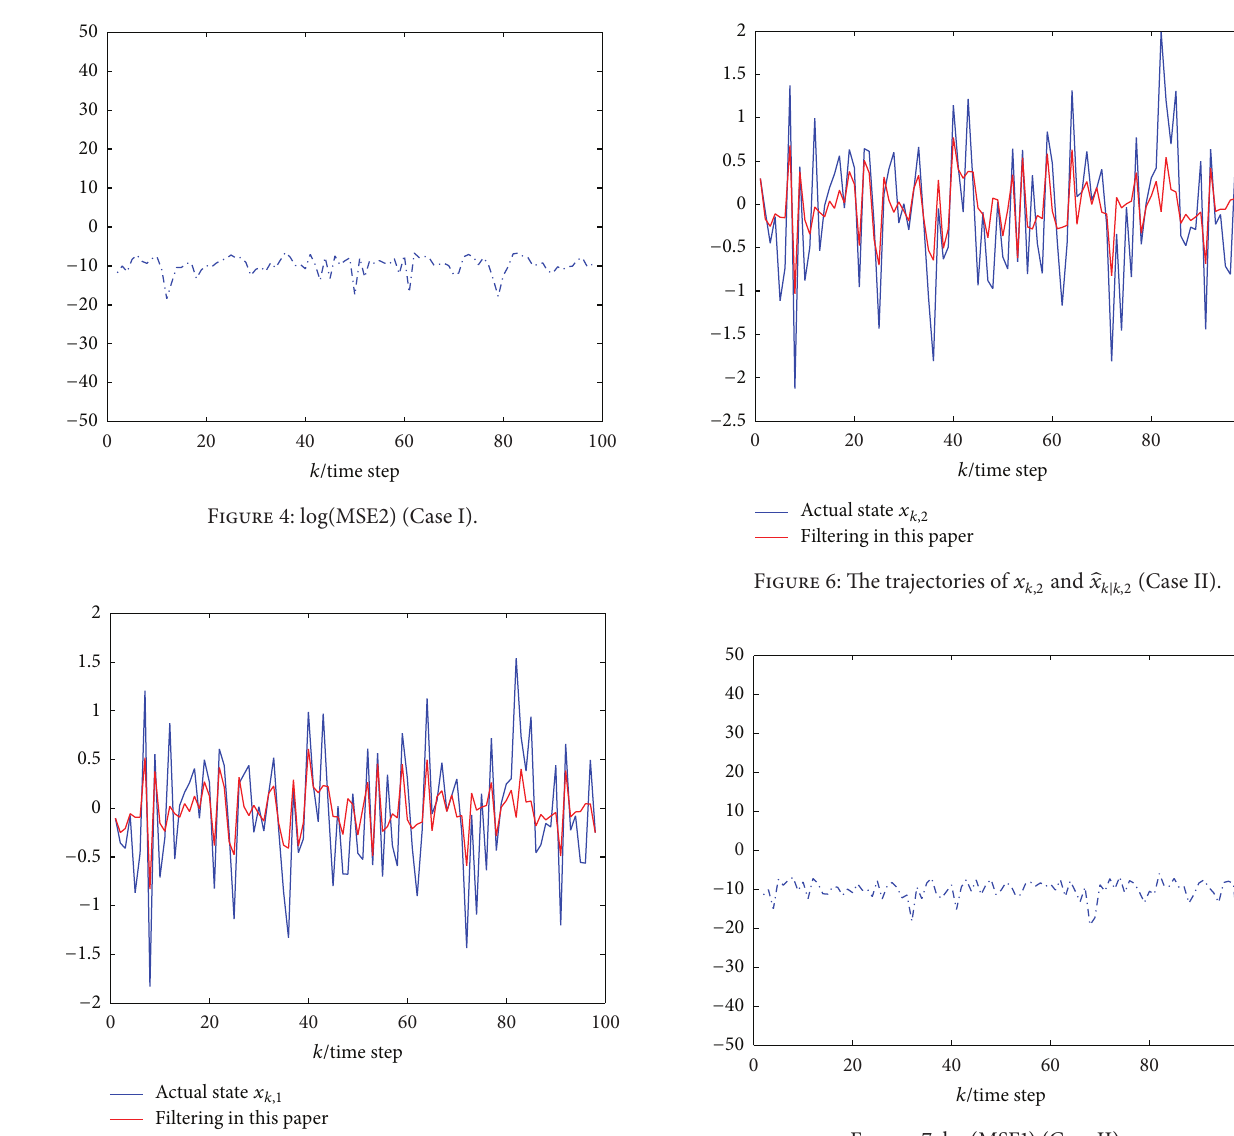
Figure 5: The trajectories of 𝑥 𝑘,1 and ̂𝑥 𝑘|𝑘,1 (Case II).